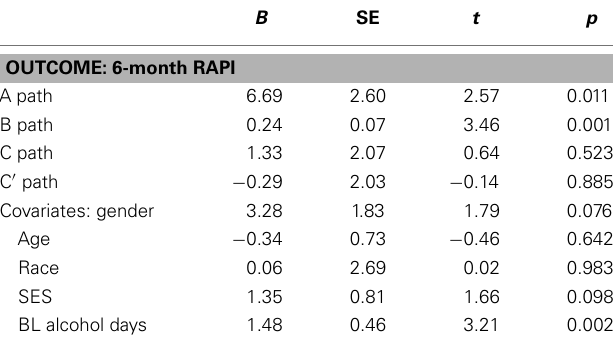
Table 2 | Parameter estimates for models, testing indirect effects of externalizing symptoms on the association between serotonin transporter genotype (A/G) and 6-month RAPI and RMPI score